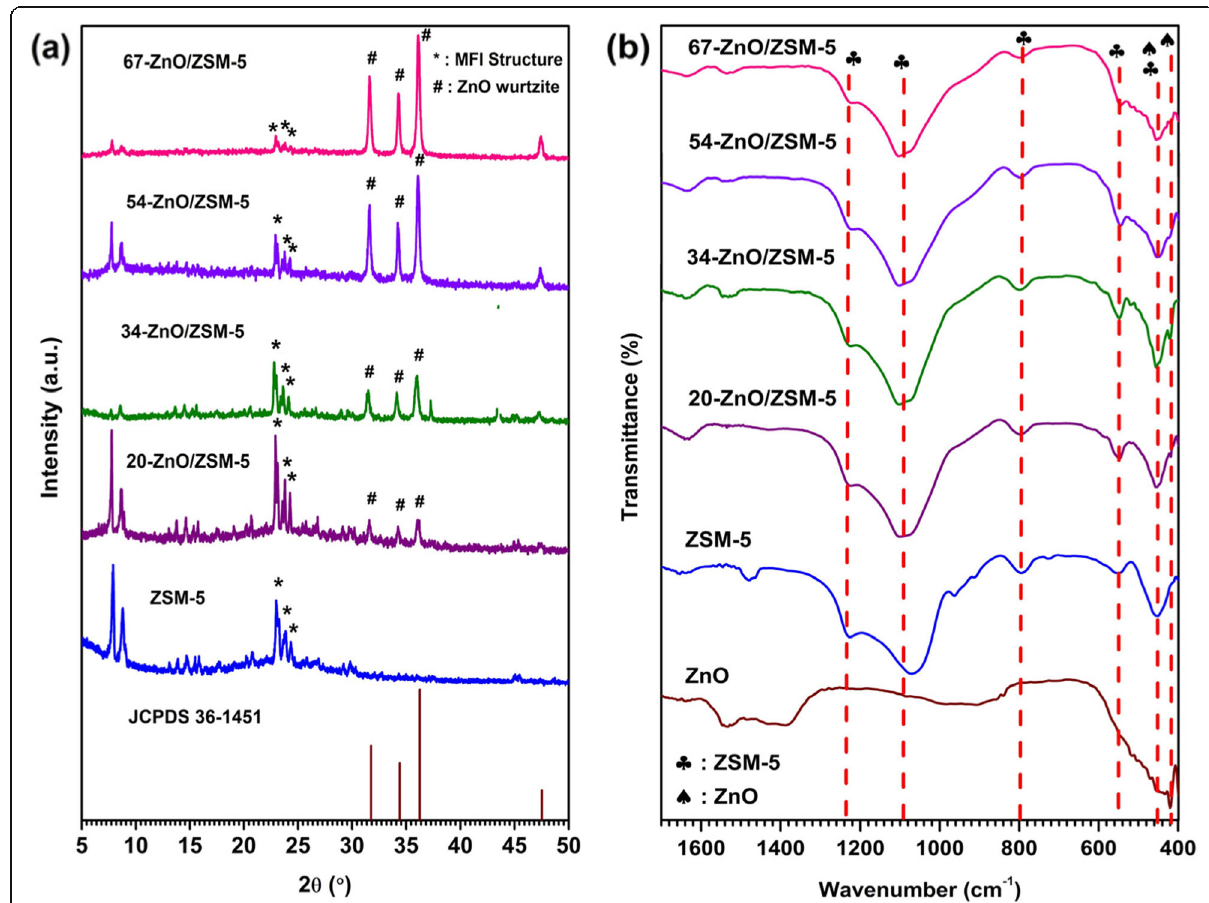
Fig. 4 Influence of ZnO on the ( a ) XRD pattern and ( b ) FTIR spectra of